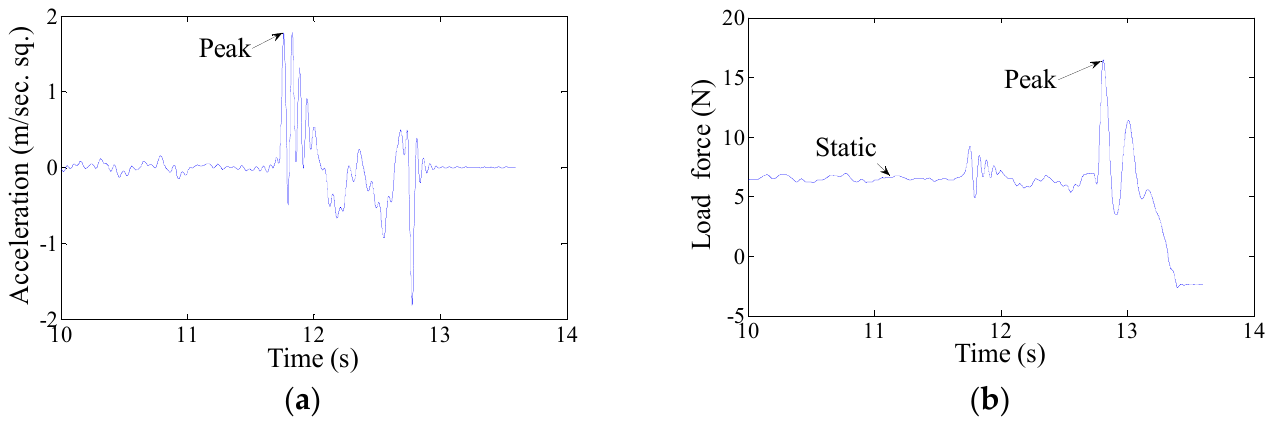
Figure 7. ( a )The sample data of acceleration for force control scheme/method 1, and ( b ) the sample data of load force for force control scheme/method 2 for an object (the medium size). Here, the positive signs/directions of the data indicate the upward object movement.